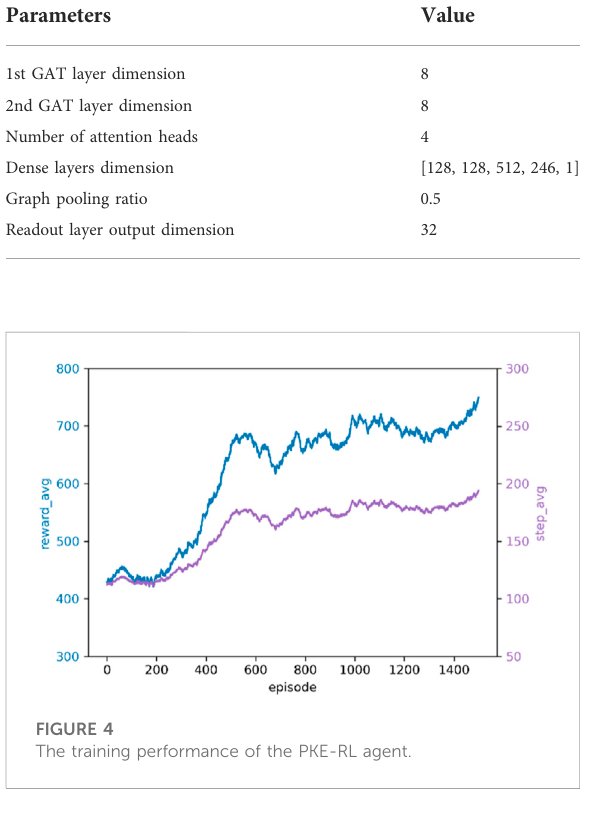
FIGURE 4 The training performance of the PKE-RL